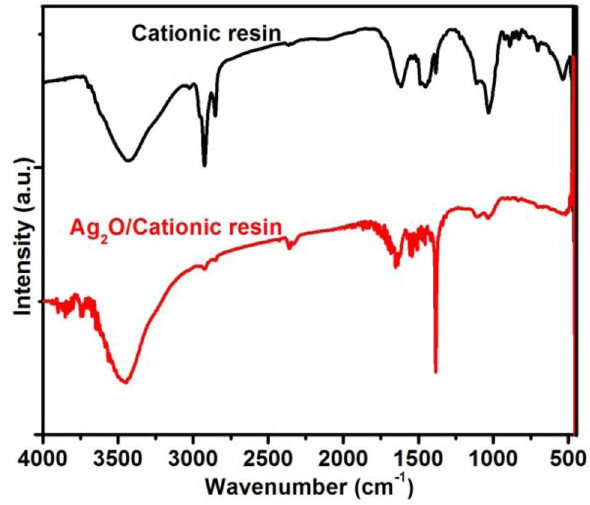
Figure 2. FTIR patterns of strong-acidic cationic resin and resin@P-Ag 2 O materials.